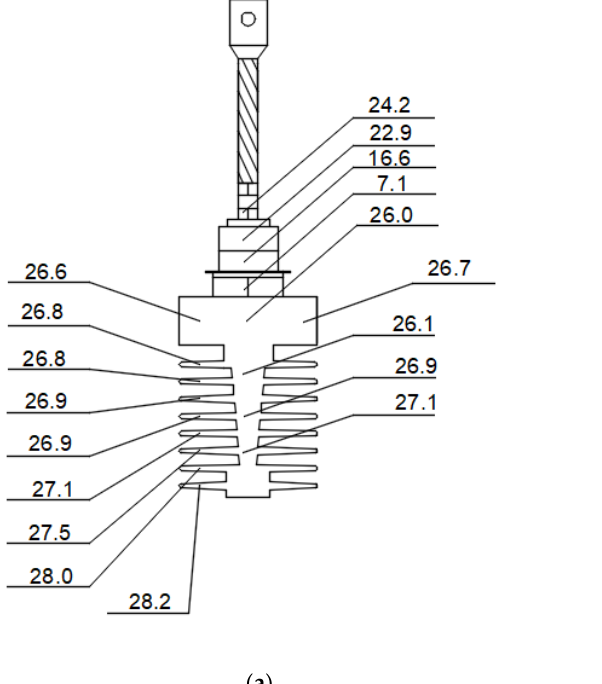
Figure 18. Differences ( T j – T s ) between the junction temperature ( T j ) and the surface temperatures ( T S ) (from Tables 6 and 7) at points presented in Figure 2 for a power of Pj = 28.80 W: ( a ) side view; ( b ) top view.